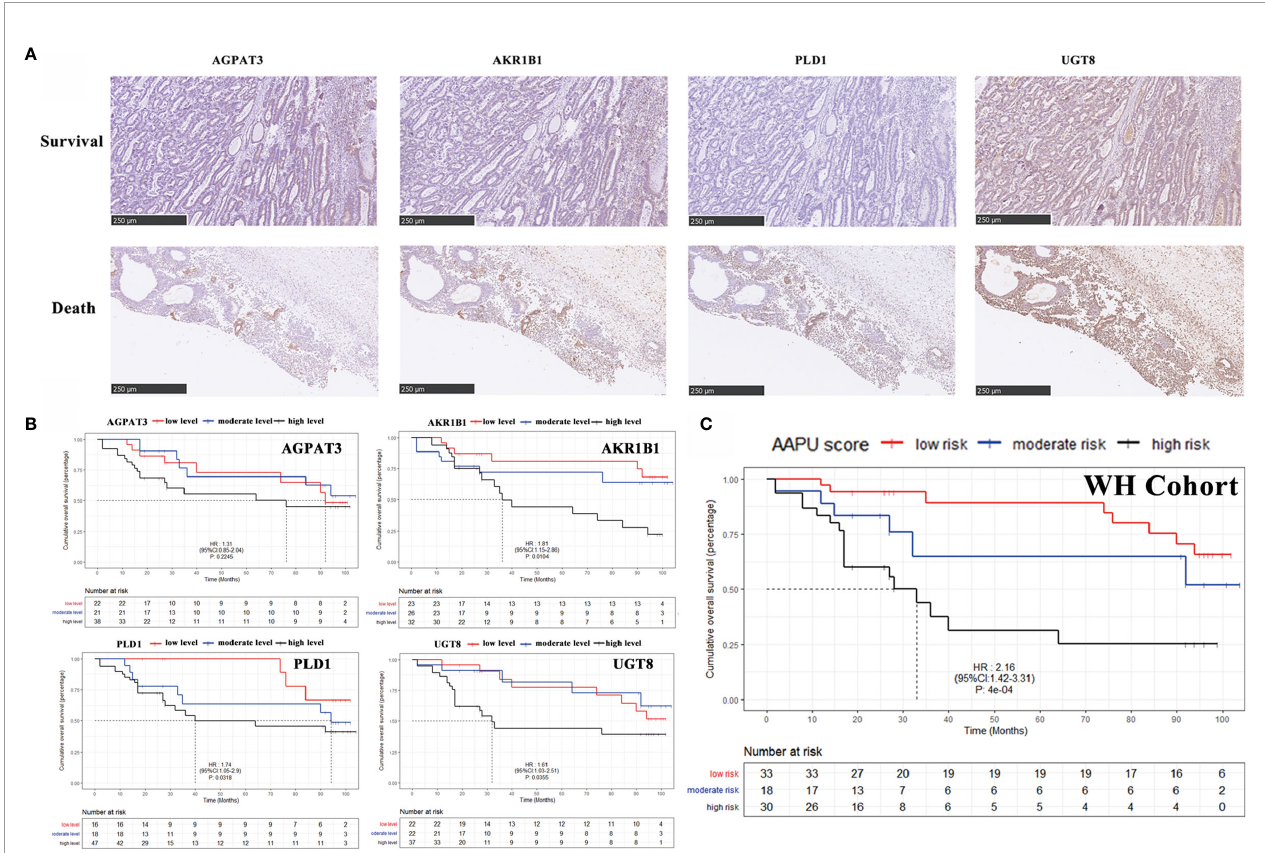
FIGURE 5 | (A) Representative images of IHC for AGPAT3, AKR1B1, PLD1, and UGT8 in GC case with a H&E staining, ×10. (B) KM survival curves of low- and high-level AGPAT3, AKR1B1, PLD1, and UGT8 in Wuhan Union Hospital cohort. (C) The KM survival curves of low-, moderate- and high-risk “ AAPU ” genes pro fi le in the WH